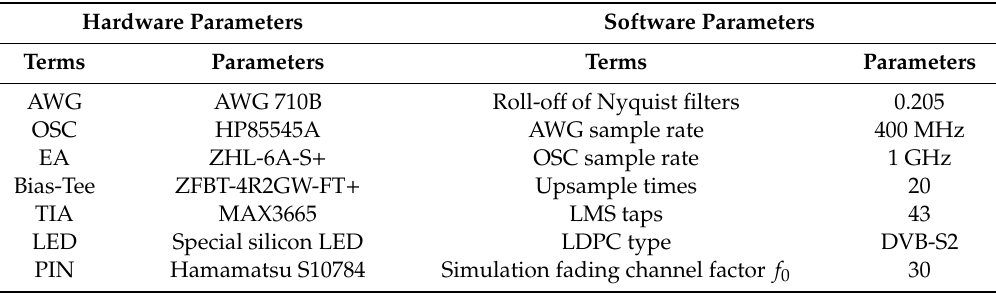
Figure 1. Experimental and simulation setup. Table 1. Detailed parameters of experimental and simulation